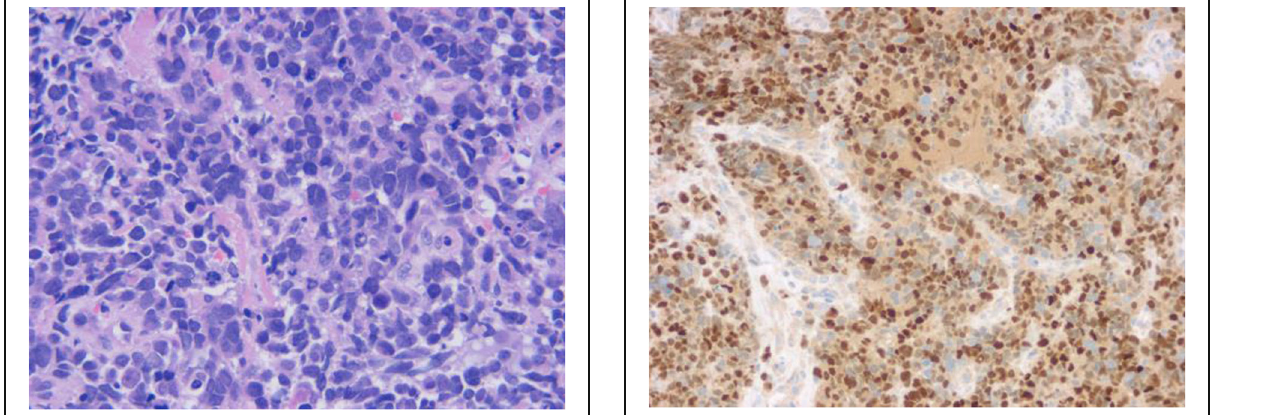
Fig. 7 En Vision method shows strong positive expression of myogenin